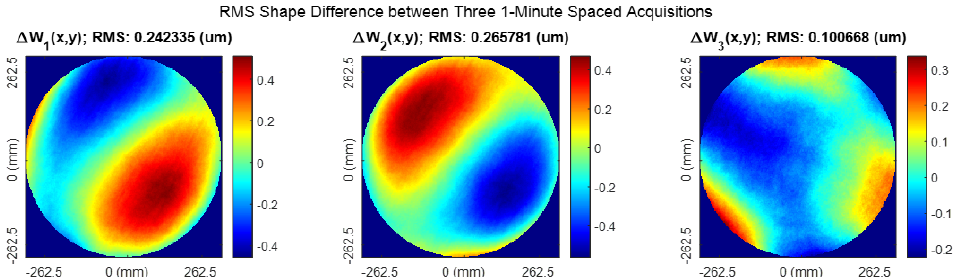
Figure 8. Three differential deflectometry measurements show the repeatability of the central 525 mm aperture. Changes within the first two minute-separated acquisitions resemble coma but flip in sign. At the end of the third minute acquisition, fluctuations damped significantly. Experience with the inflation unit hints that the pressure control unit strongly converges towards the setpoint, but sufficient iterative convergence occurs on longer timescales. Here, the 700 Pa pressure setpoint was met and held to the 10 Pa resolution indicated by the unit.